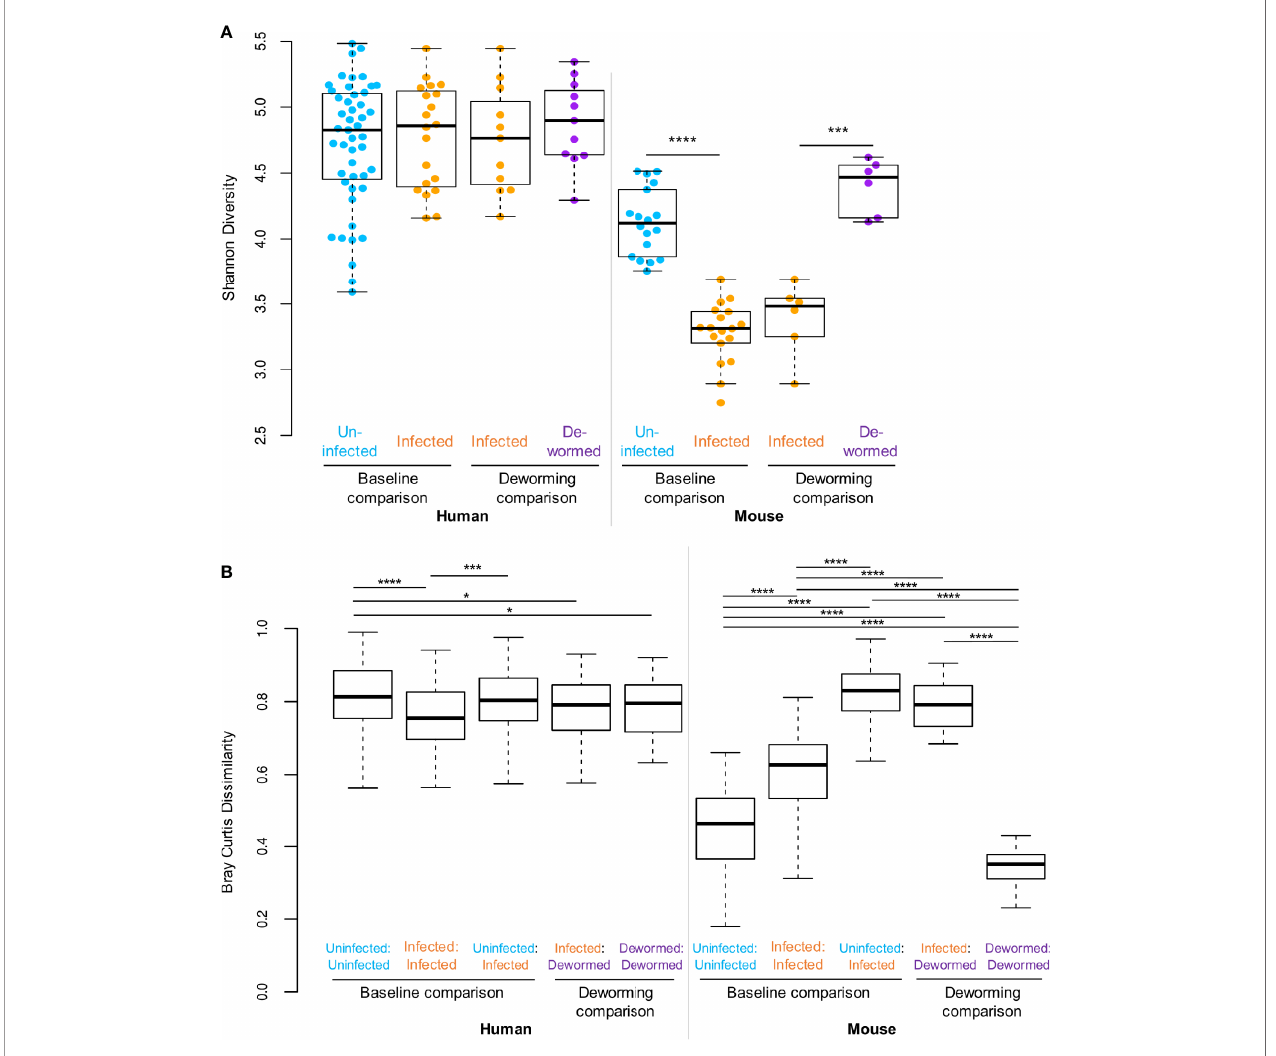
FIGURE 2 | Statistical comparisons of diversity measures. (A) Shannon (alpha) diversity values for all samples in each sample set. (B) Bray-Curtis dissimilarity (beta diversity) values either between samples from the same sets, or between sample sets. * P ≤ 0.05, *** P ≤ 0.001, **** P ≤ 0.0001, according to ANOVA with Tukey HSD post-hoc test. F-statistic values for human and mouse were 13.8 and 464.6, respectively (P < 10 − 5 in both